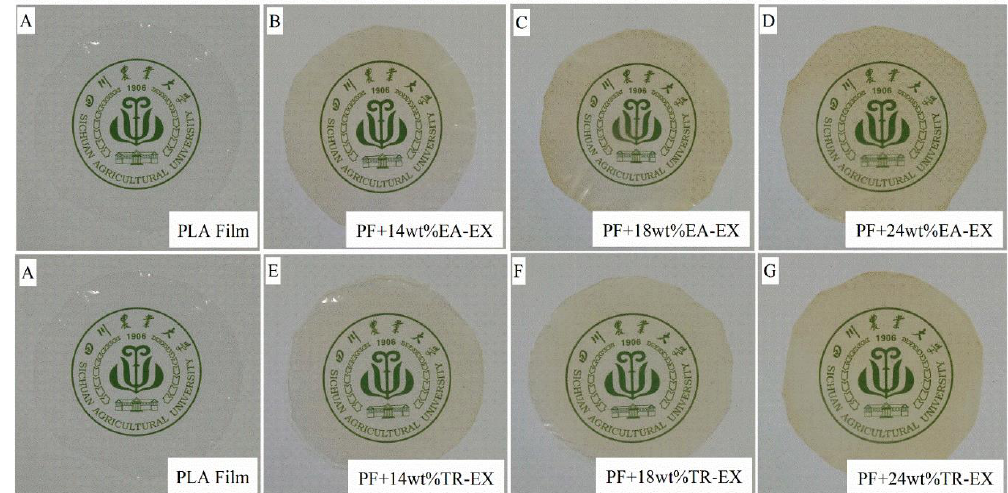
Figure 6. Photograph images of the PLA film (PF): ( A ), UV shielding films (UV-PF) with 14 wt% EA-EX ( B ), UV-PF with 18 wt% EA-EX ( C ), UV-PF with 24 wt% EA-EX ( D ), UV-PF with 14 wt% TR-EX ( E ), UV-PF with 18 wt% TR-EX ( F ) and UV-PF with 24 wt% TR-EX ( G ).